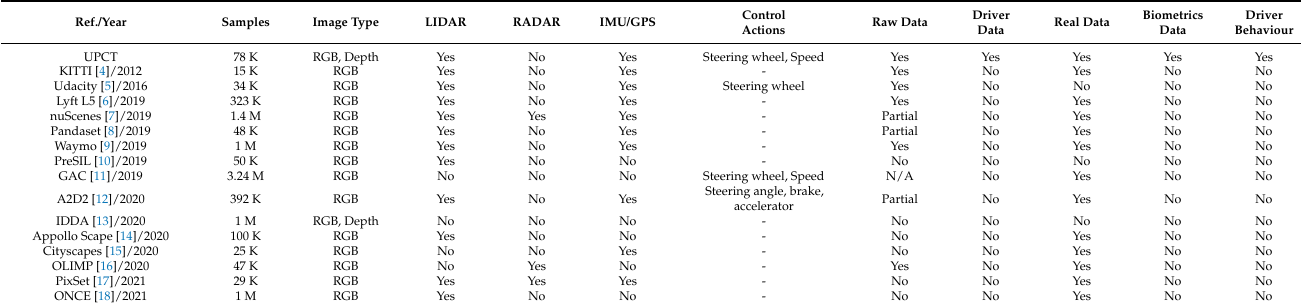
Table 1. Comparison of the main Datasets.